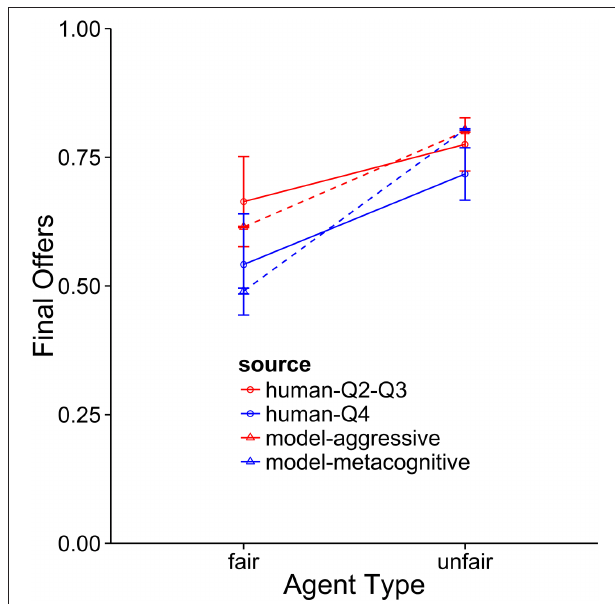
FIGURE 9 | A comparison of the aggressive and metacognitive models to human data with respect to final offer usage. Separate lines represent different groups of humans or model types.